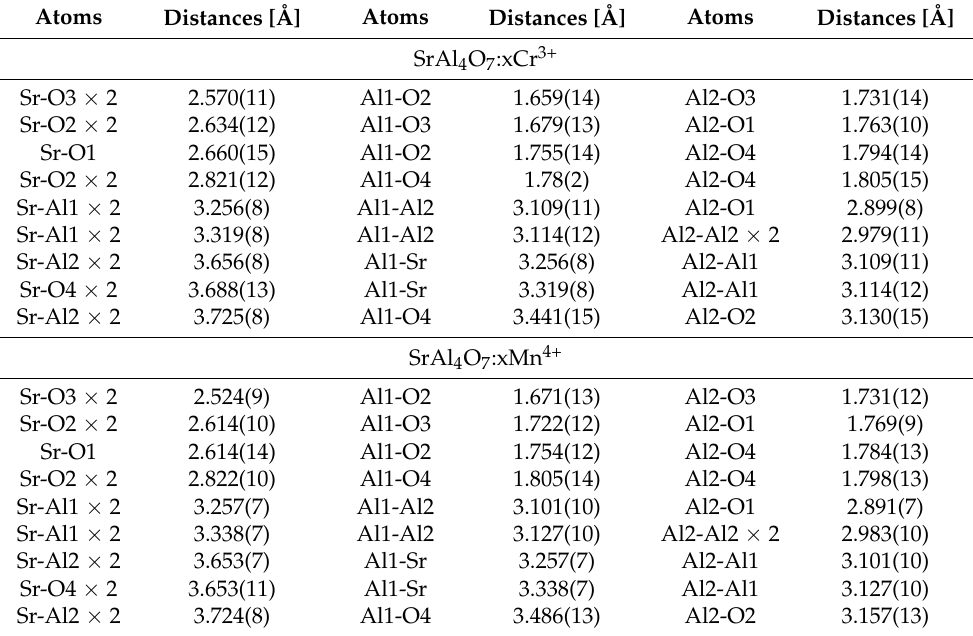
Table 2. Selected interatomic distances in SrAl 4 O 7 :xCr 3+ and SrAl 4 O 7 :xMn 4+ (x = 0.005) structures annealed at 1100 ◦